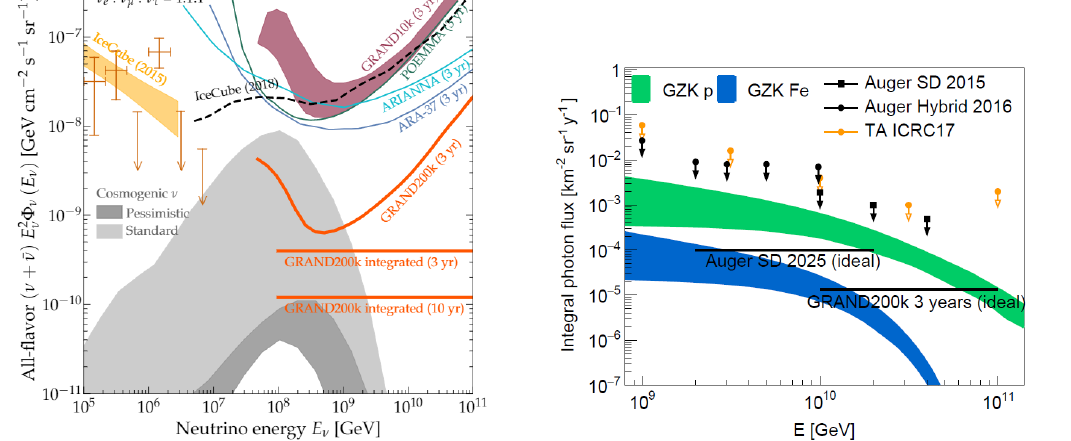
Figure 1: Left : Predicted cosmogenic neutrino flux, compared to experimental up- per limits and sensitivities of several existing and projected experiments. The gray- shaded regions were obtained through the combined fit of energy spectrum and mass- composition using Auger data and UHECR simulations [ 4 ] . Right : Estimated upper limits on UHE photon sensitivity for GRAND after 3 years of operation. For reference, the predicted cosmogenic UHE photon flux for pure-proton and pure-iron scenarios, as estimated in [ 5 ] was also shown. For comparison, we include the existing upper limits from Auger and the Telescope Array (TA) and the projected reach of Auger by